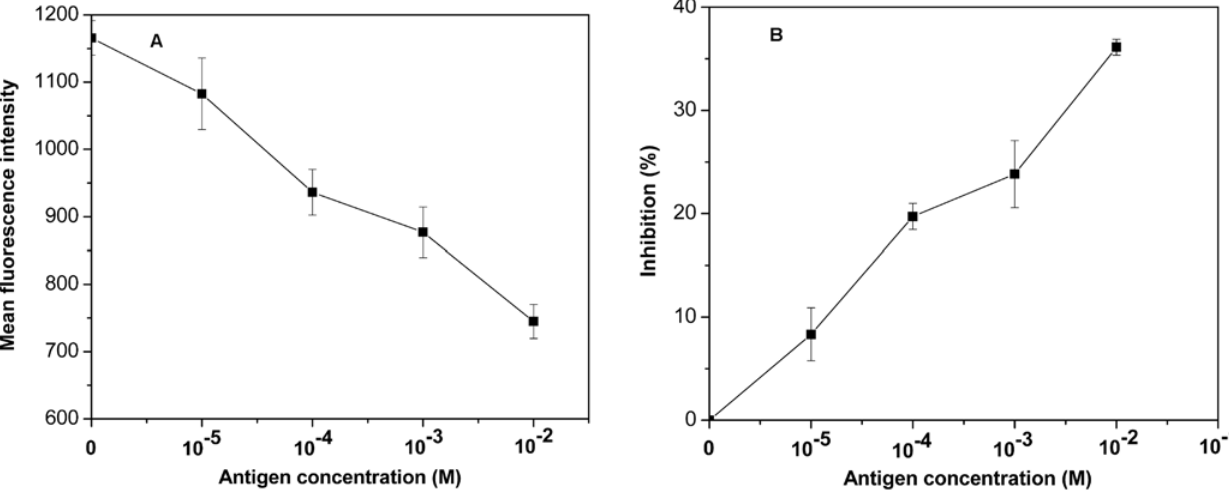
Figure 5. Inhibition of the binding of mAb-DR FITC by unlabeled TP5. Results were shown by the decrease of MFI (A) and the percent inhibition of MFI (B). The data points shown were the mean values of triplicates 6 SD.